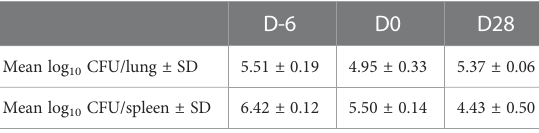
TABLE 4 M.abscessus burden in the lungs and spleens of mice.